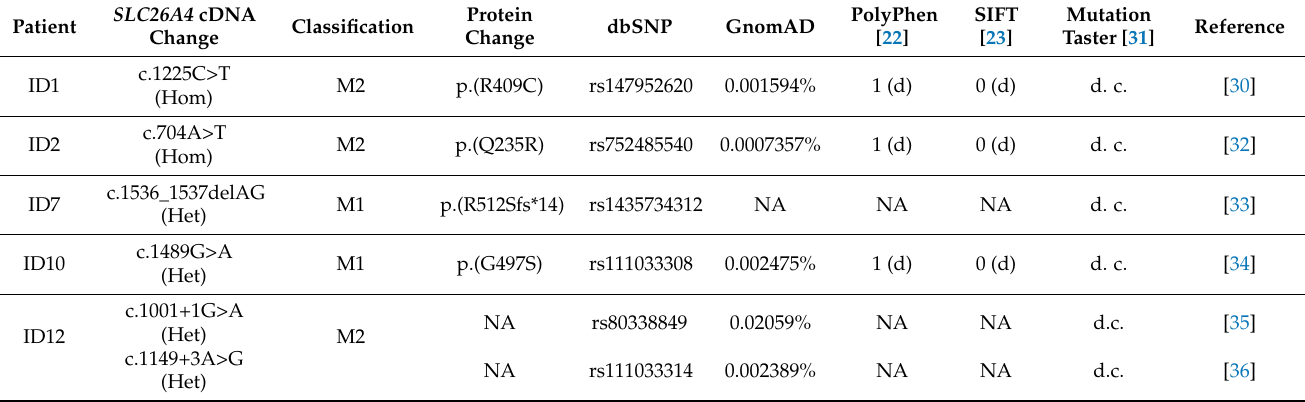
Table 2. SLC26A4 gene variants identified in the selected cohort of suspected PDS